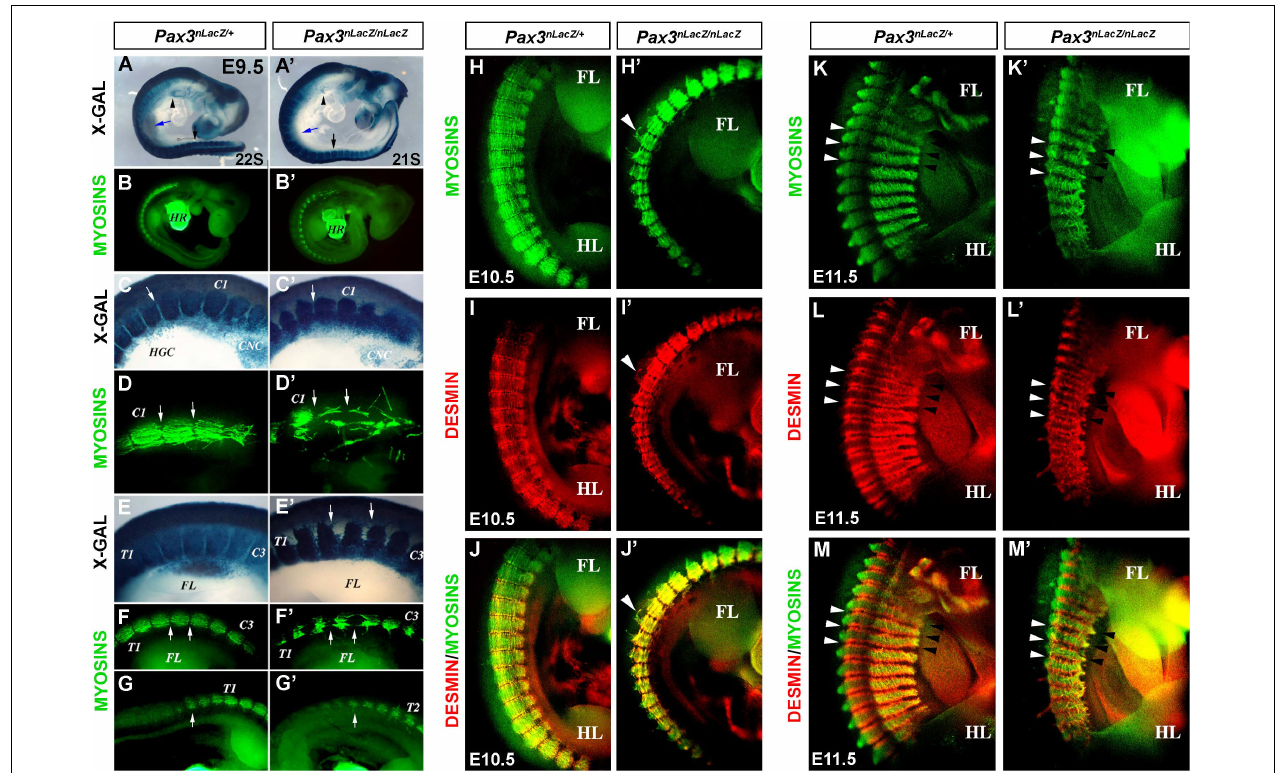
FIGURE 1 | Characterization of the myotome of Pax3 -mutant embryos. (A,A (cid:48) ) X-GAL staining of whole-mount control ( Pax3 nLacZ / + ) and Pax3 -mutant ( Pax3 nLacZ / nLacZ ) embryos at E9.5 (arrow head, hypoglossal cord; blue arrow, forelimb; black arrow, hindlimb). (B,B (cid:48) ) Whole-mount immunostaining to visualize muscle Myosins in control ( Pax3 nLacZ / + ) and Pax3 -mutant ( Pax3 nLacZ / nLacZ ) embryos at E9.5 (HR, heart). (C,C (cid:48) ) High magnification of X-GAL staining of whole-mount control ( Pax3 nLacZ / + ) and Pax3 -mutant ( Pax3 nLacZ / nLacZ ) embryos in the cervical region at E9.5 (C1, Cervical Somite 1; HGC, hypoglossal cord; CNC, cardiac neural crest cells; arrow, somite boundary). (D,D (cid:48) ) High magnification of whole-mount immunostaining to visualize muscle Myosins in control ( Pax3 nLacZ / + ) and Pax3 -mutant ( Pax3 nLacZ / nLacZ ) embryos at the cervical region at E9.5 (arrows, somite boundaries). (E,E (cid:48) ) High magnification of X-GAL staining of whole-mount control ( Pax3 nLacZ / + ) and Pax3 -mutant ( Pax3 nLacZ / nLacZ ) embryos in the thoracic region at E9.5 (T1, Thoracic Somite 1; C3, Cervical Somite 3; arrows, Dorsal root ganglia lacking in the mutant embryo). (F–G (cid:48) ) High magnification of whole-mount immunostaining to visualize muscle Myosins in control ( Pax3 nLacZ / + ) and Pax3 -mutant ( Pax3 nLacZ / nLacZ ) embryos in the thoracic region at E9.5 (T1, Thoracic Somite 1; T2, Thoracic Somite 2; C3, Cervical Somite 3; FL, forelimb; arrows, somite boundaries). (H–M (cid:48) ) Whole-mount immunostaining to visualize muscle Myosins (H,H (cid:48) ,K,K (cid:48) ) , Desmin (I,I (cid:48) ,L,L (cid:48) ) and the merge (J,J (cid:48) ,M,M (cid:48) ) in control ( Pax3 nLacZ / + ) and Pax3 -mutant ( Pax3 nLacZ / nLacZ ) embryos at E10.5 (H–J (cid:48) ) and E11.5 (K–M (cid:48) ) (FL, forelimb; HL, hindlimb; white arrow heads, epaxial somite boundary; black arrow heads, hypaxial somite